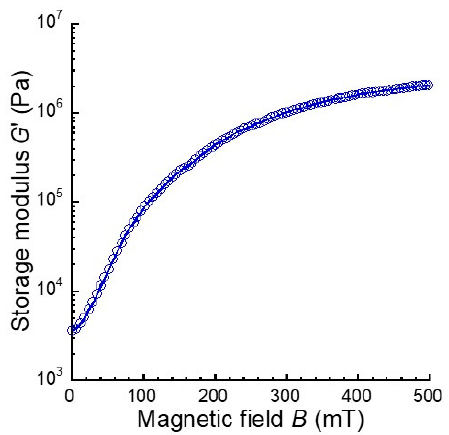
Figure 3. Magnetic field dependence of the storage modulus for magnetic elastomers used in CT observations (CI 70 wt%, DOP 70 observations (CI 70 wt%, DOP 70 wt%).